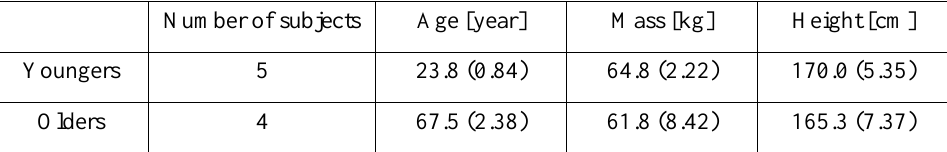
Table 1 Mean (s.d.) age, mass, and height of the nine subjects